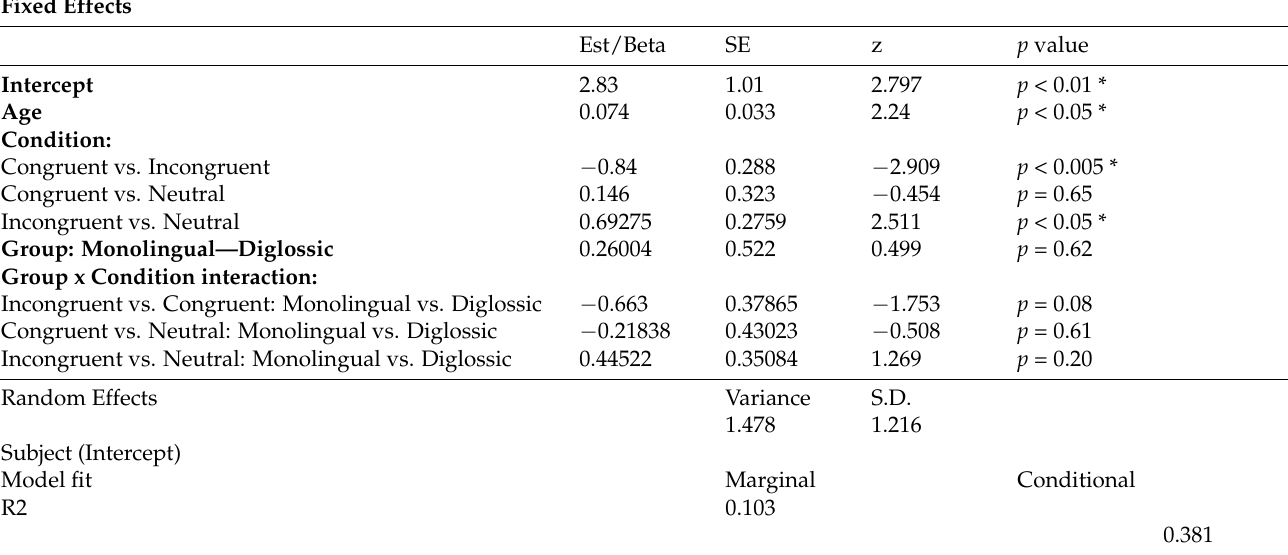
Table 1. Accuracy results for the Flanker